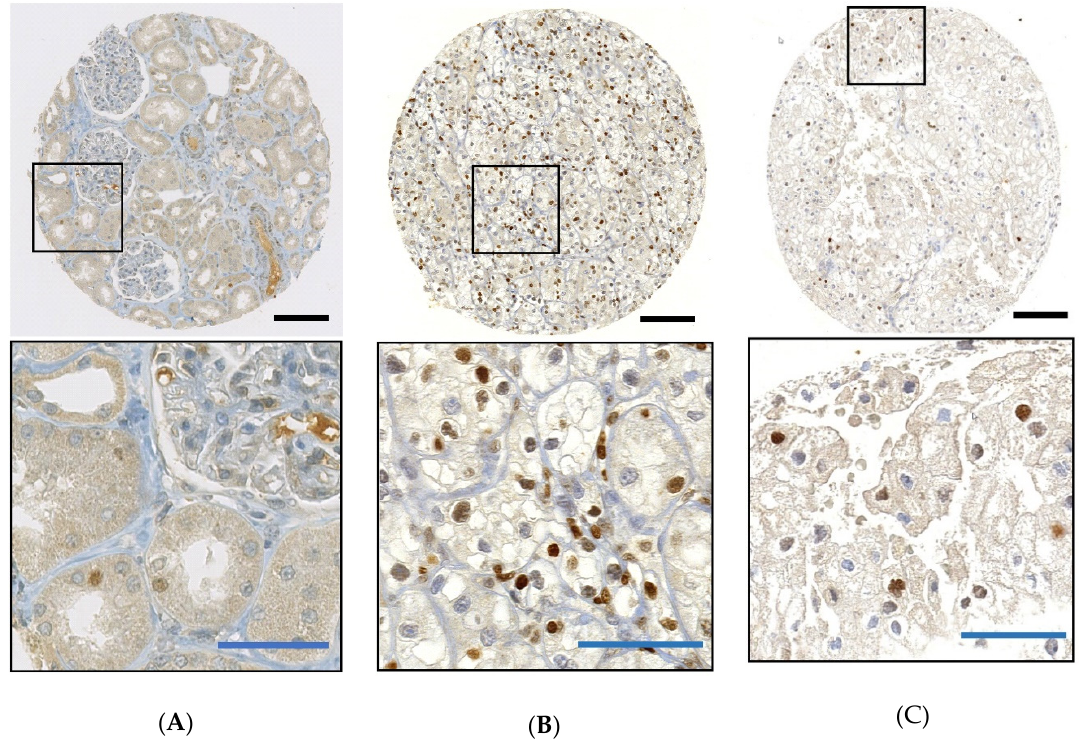
Figure 4. Immunohistochemistry of CDKN1A in the Swiss cohort. ( A ) Weak nuclear CDKN1A expression in some tubular cells in normal kidney; ( B ) strong nuclear CDKN1A expression in clear cell RCC; ( C ) strong nuclear CDKN1A expression in chRCC. Black bars: 100 µ m; blue bars: 10 µ m.